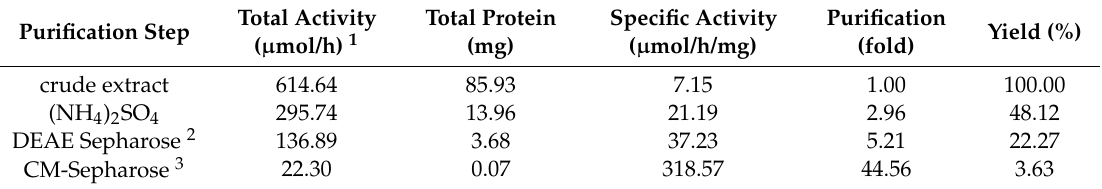
Table 1. Summary of the Purification Process of β -Glycosidases from B. calycina petals.